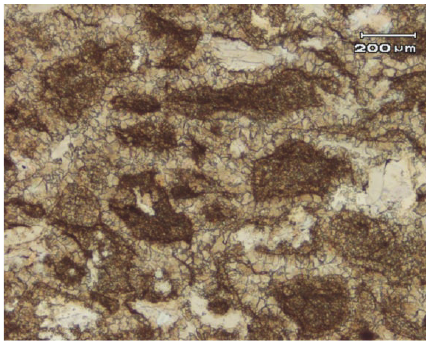
Figure 5: Dolarenite, S2, 3655.65 ∼ 3655.84 m, T 1 j 2 .